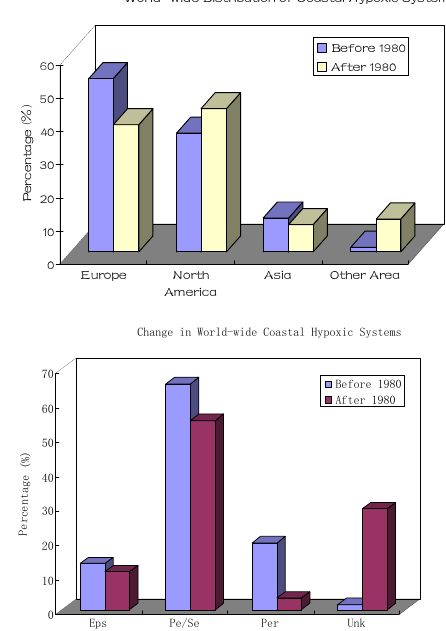
Figure 2b. Fig. 2. Comparison of world-wide distribution of hypoxic systems before and after 1980, with (a) hypoxic systems per geographic cat- egory, and (b) classification according to type of hypoxia: Eps – episodic, Pe/Se – periodic and seasonal, Per – persistent, and Unk – for which the hypoxia behavior is not well recognized (i.e. un- known). Data are from Diaz and Rosenberg,